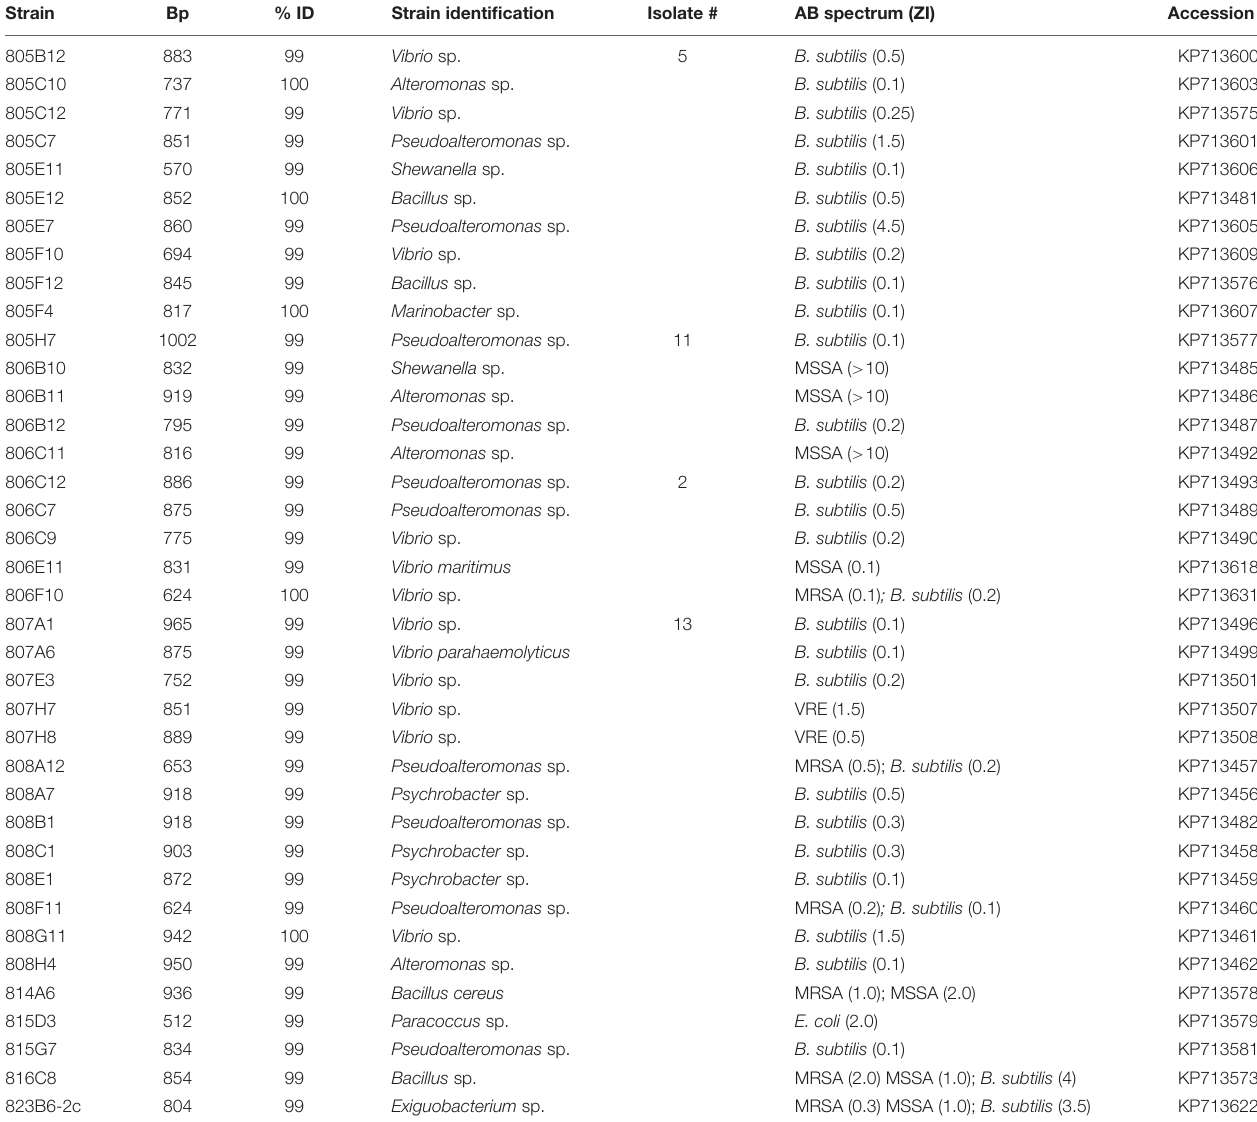
( Table 2 ). Of eight active isolates genetically identified, 16S rDNA sequence analysis revealed 3 bacterial genera including Vibrio spp. ( n = 4), Photobacterium spp. ( n = 3), and a Staphylococcus sp. ( n = 1).